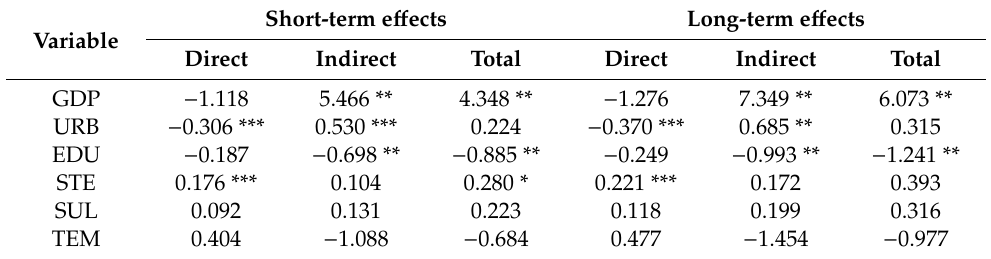
Table 4. The direct, indirect, and total e ff ects of Dynamic-SDM in the short- and long-term e ff ects. Short-term e ff ects Long-term e ff ects Variable Direct